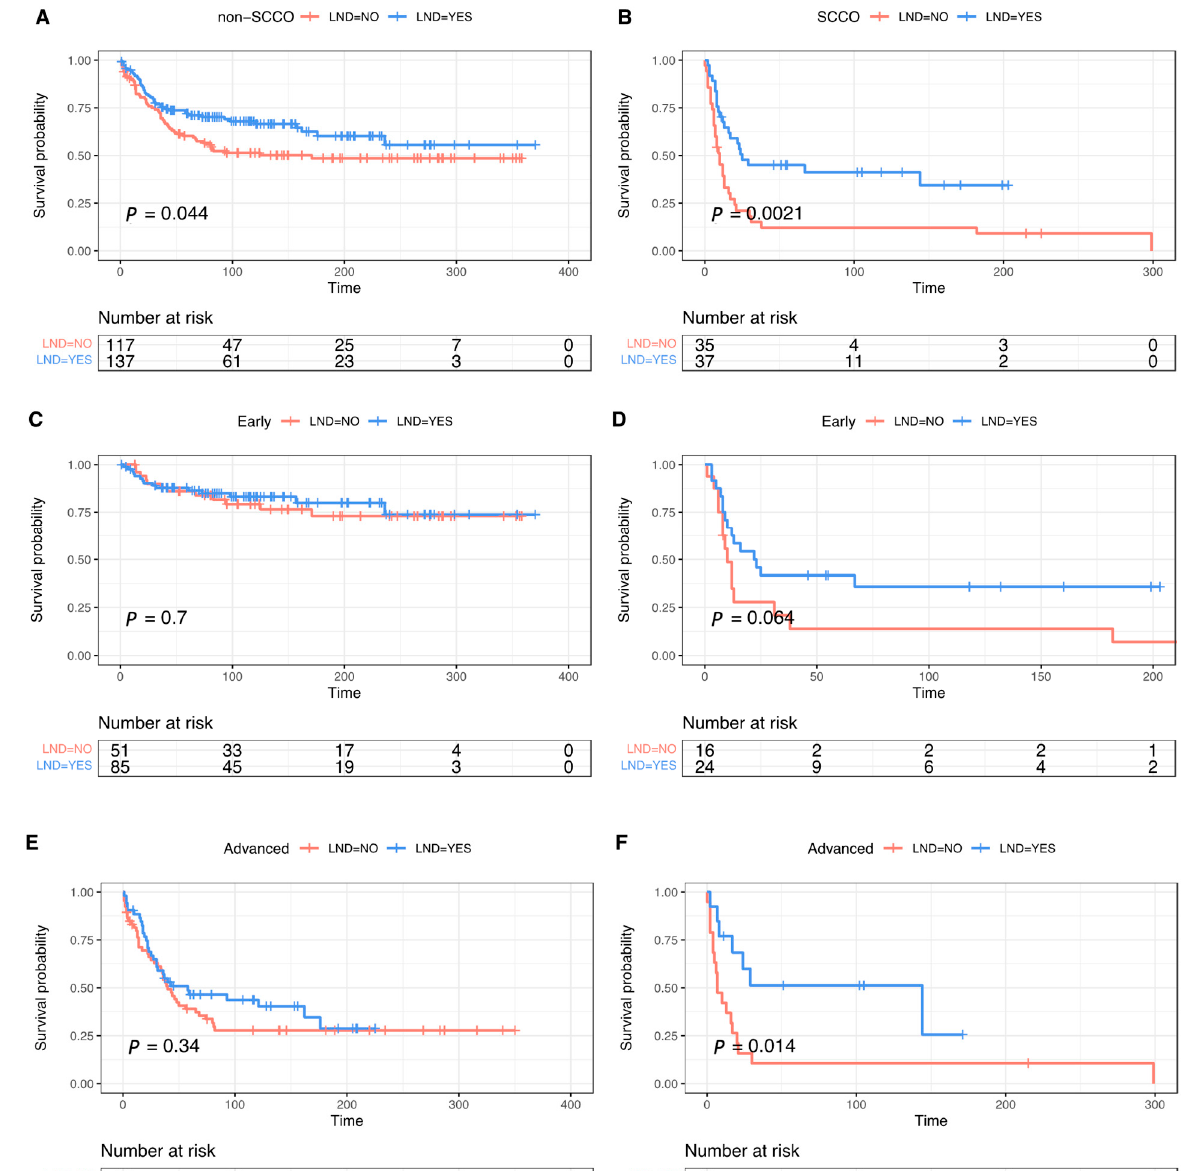
Figure 3. Survival curves of overall survival among patients with all stage ( A , B ), early stage ( C , D ), and advanced stage ( E , F ) in non-SCCO and SCCO in matched cohort divided by